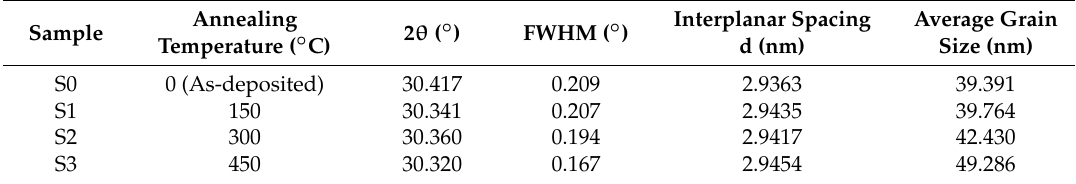
Table 1. XRD results of θ –2 θ scans for the films before and after annealing at different temperatures.